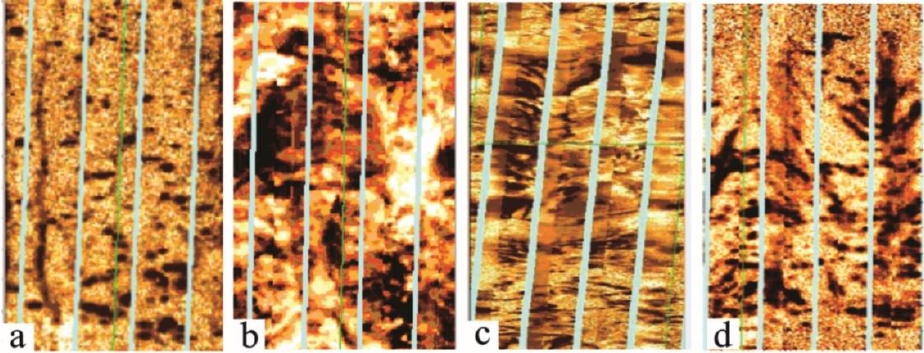
Figure 8. FMI logging characteristics of four void space types: ( a ) solution-filling type; ( b ) cement- reducing type; ( c ) solution-filling breccia type; ( d ) solution-enlarging fractures and vugs type.